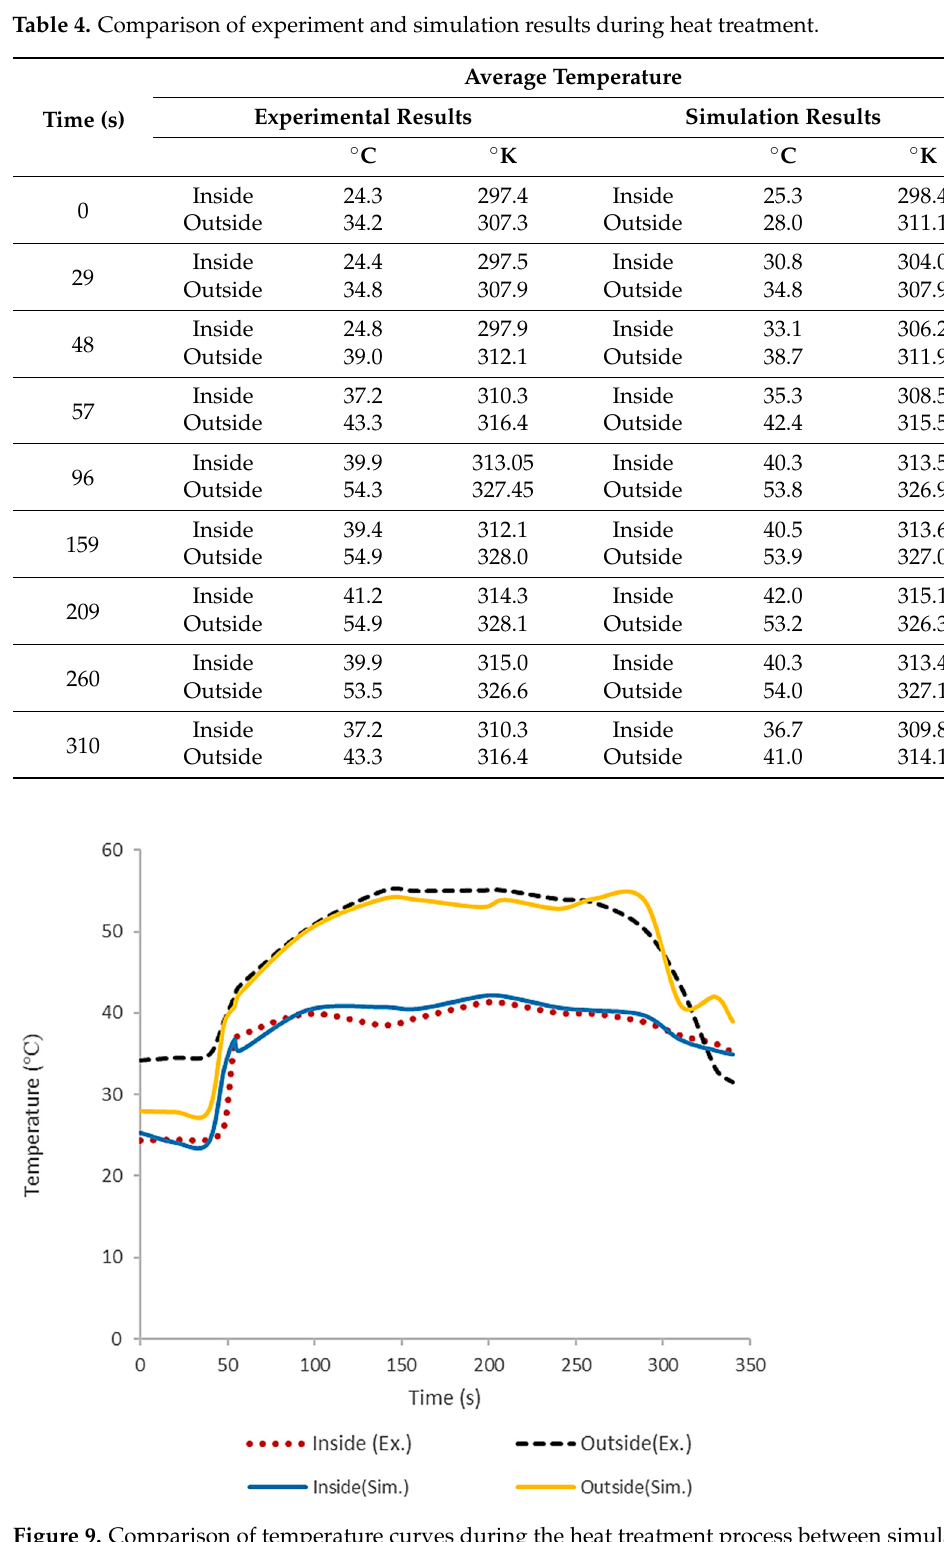
Figure 9. Comparison of temperature curves during the heat treatment process between simulation experimental values on the bark surface (Outside) and in the phloem (Inside). Table 4. Comparison of experiment and simulation results during heat treatment.